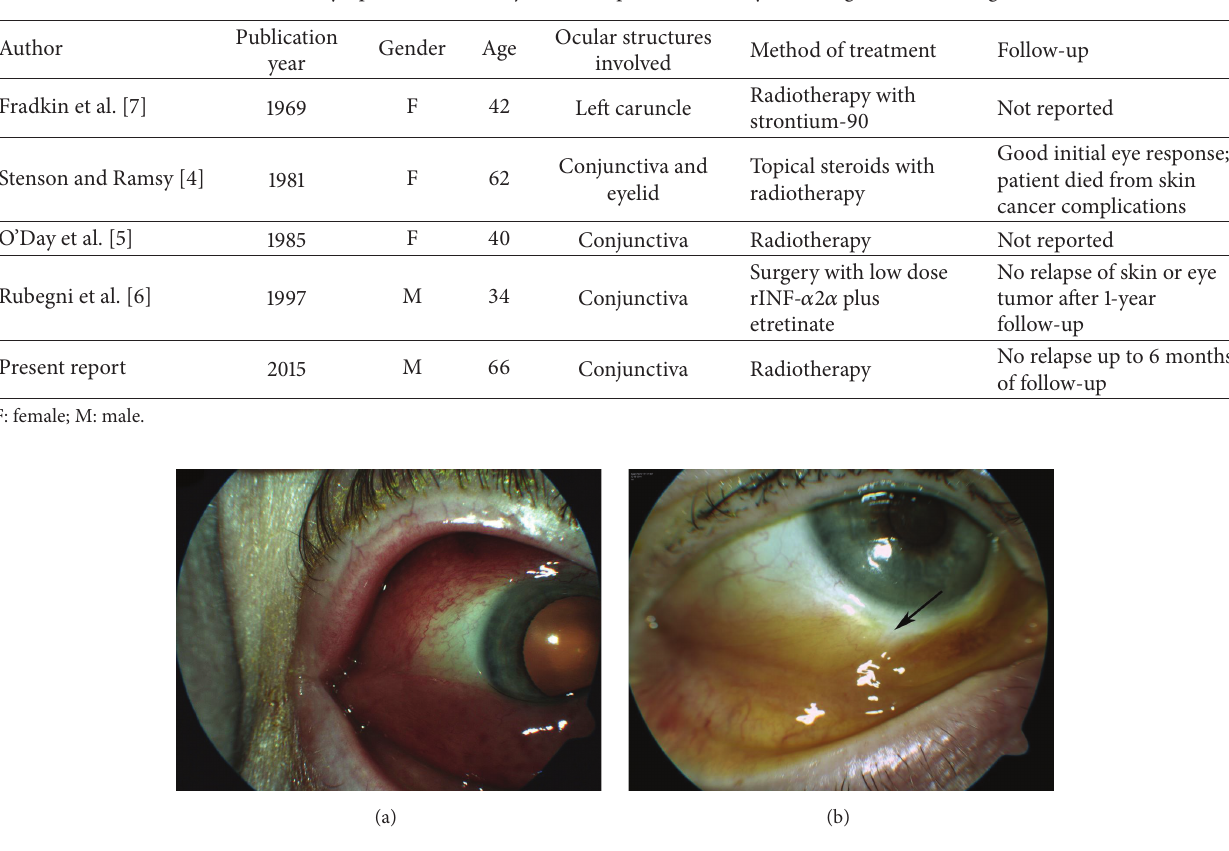
Figure 1: Slit lamp images of the right eye. (a) Erythematous flesh-like tumor affecting most of the conjunctiva, which is more prominent in the inferior location. (b) After treatment, there was significant lesion regression. Note the scar at the biopsy site